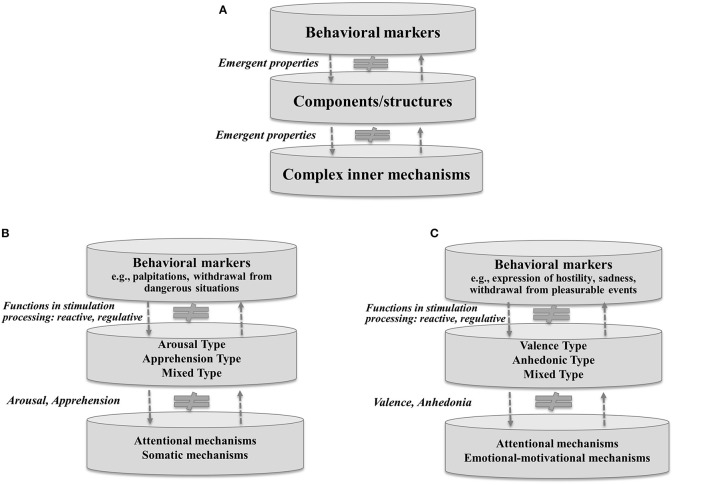
The organization of (A) personality trait/type, (B) anxiety types, (C) depression types according to the three-level hierarchy (cf. Fajkowska, 2013, 2015).